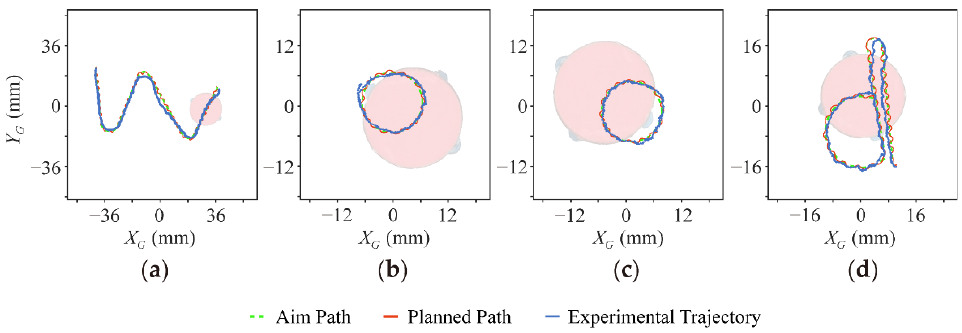
Figure 9. ( a )–( d ) The trajectories of the robot fitting all the letters of WOOD (in honor of Professor Robert J.